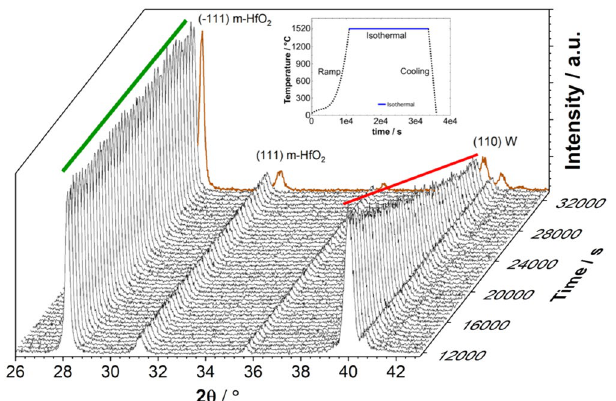
Figure 4. In-situ X-ray diffraction measurements of a 3-layer-system performed during isothermal annealing at 1520 °C for 6 h. The inset shows the whole annealing experiment with the isothermal part marked by a thick blue line. The (− 111) peak of the monoclinic HfO 2 phase is unchanged, however, the (110) peak of the bcc W phase is decreased successively. The last diffractogram colored in brown is measured at room temperature, at the end of the annealing